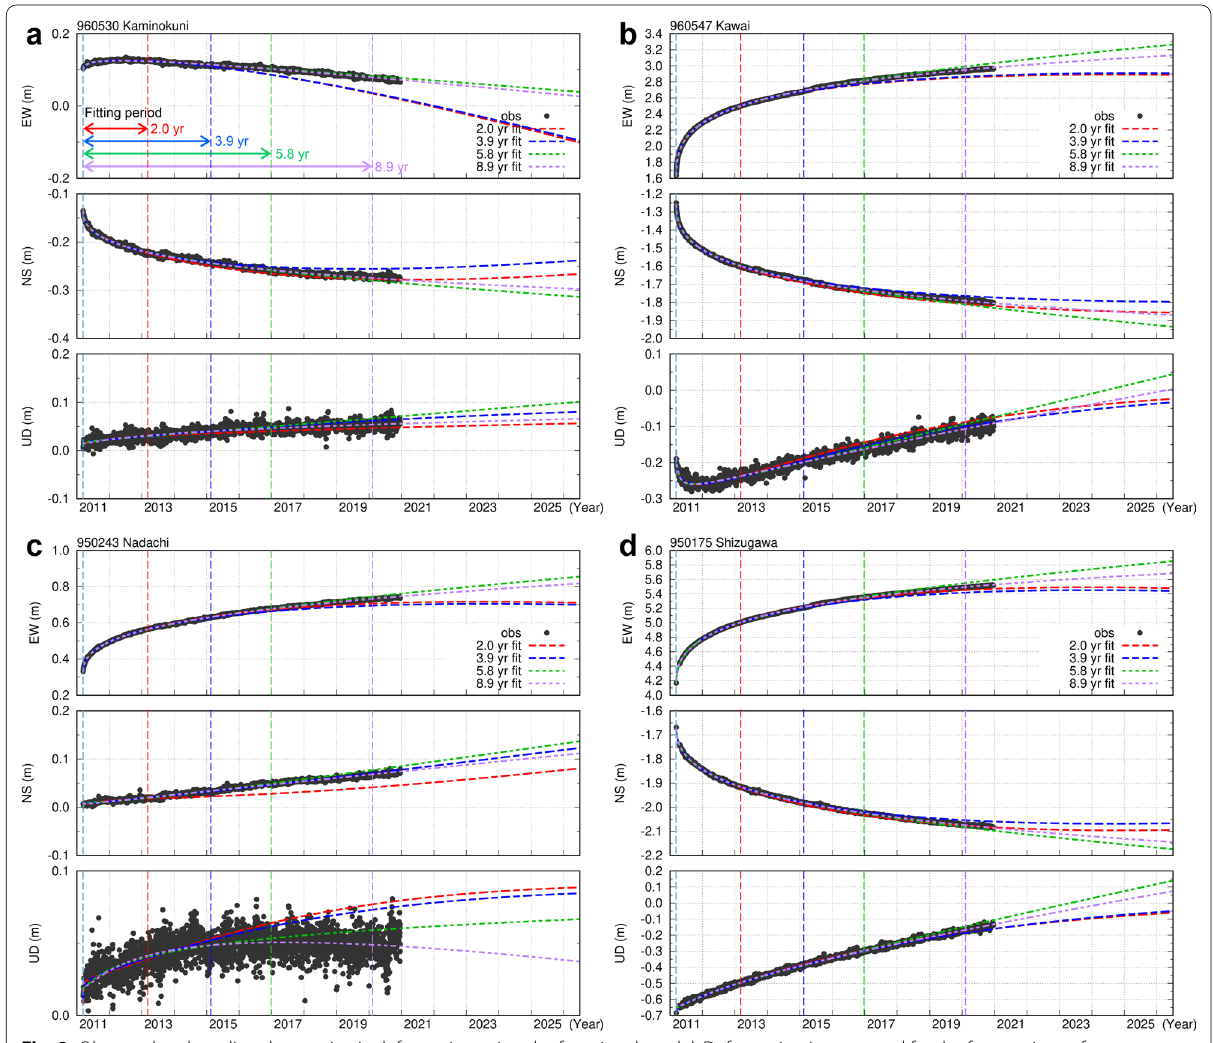
Fig. 2 Observed and predicted postseismic deformation using the functional model. Deformation is presented for the four stations of a Kaminokuni, b Kawai, c Nadachi, and d Shizugawa (Fig. 1). The three components of east–west (EW), north–south (NS), and up–down (UD) were drawn for each station from the day after the 2011 Tohoku-Oki earthquake to 2026.5. Black dots represent the daily observations. Dashed lines depict the time series of predicted values for each fitting period (2.0, 3.9, 5.8, and 8.9